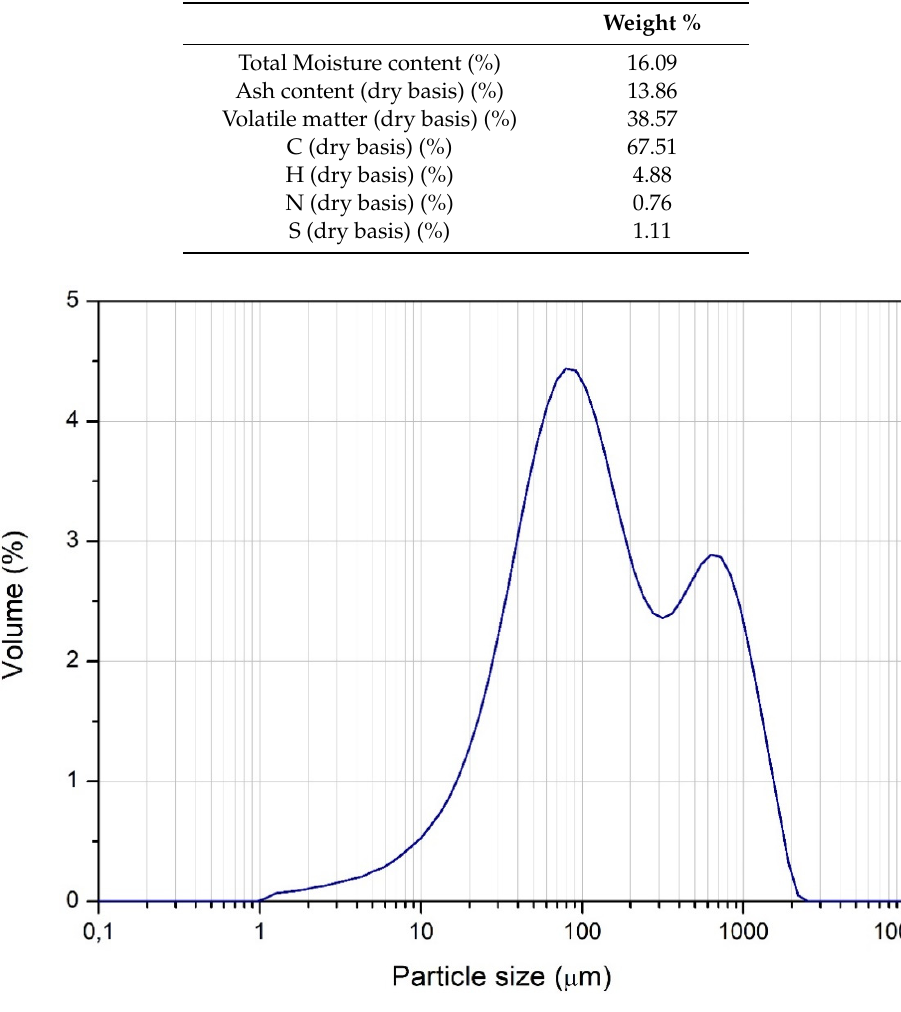
Figure 2. Particle size distribution of lignite .